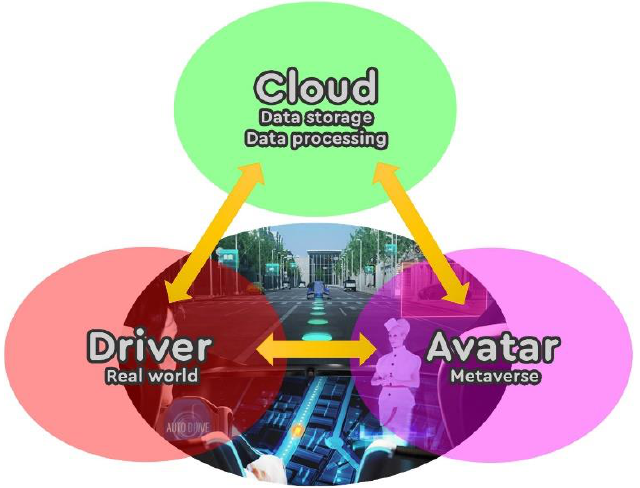
Figure 1. Metaverse implementation for autonomous driving systems.